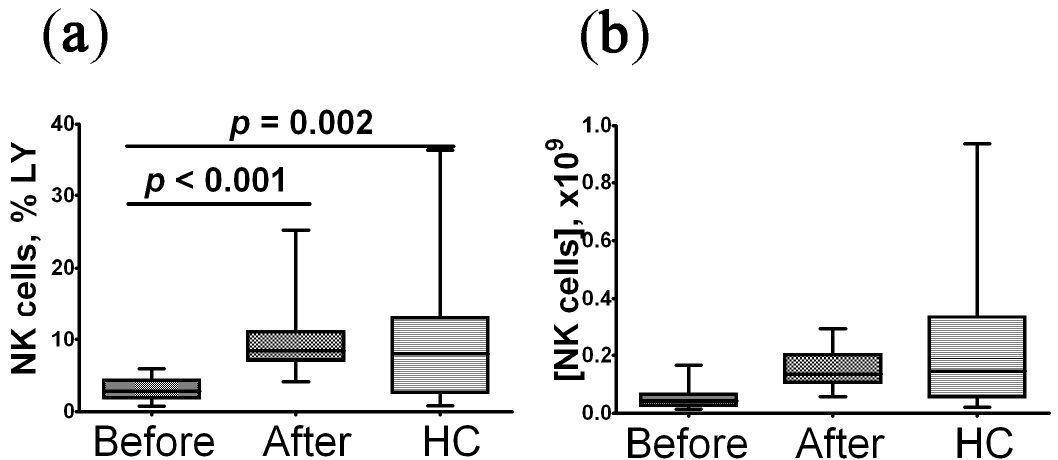
Figure 2. Imbalanced relative and absolute levels of peripheral blood CD8 + NK cells in convalescent COVID-19 individuals before ( n = 29) and after ( n = 29) recombinant human IL-2 treatment vs. the healthy control group (HC, n = 30). ( a , b )—CD8 + NK cells frequencies (% from total lymphocytes subset) and absolute numbers (number of cells in 1 litter), respectively. The statistical analysis was performed with the Mann–Whitney U test.